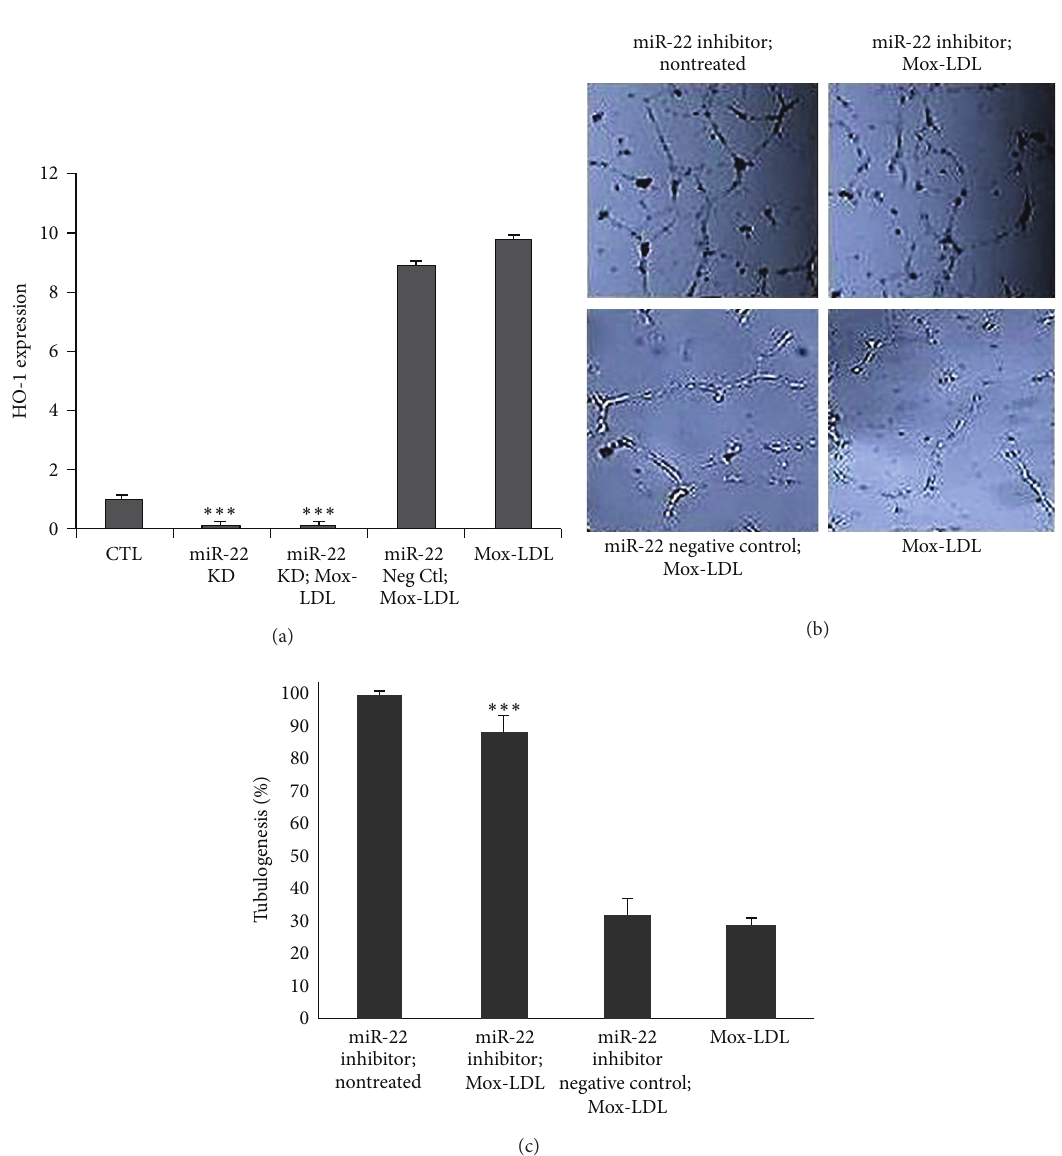
Figure 6: (a) Differential HO-1 expression between HUVECs submitted to different treatments: CTL (control mock-treated cells), miR- 22 K.D (cells treated with miR-22 inhibitor), miR-22 K.D; Mox-LDL (cells treated with miR-22 inhibitor and Mox-LDL), miR Neg Ctl; Mox-LDL (cells treated with control miR and Mox-LDL), and Mox-LDL (cells treated with Mox-LDL). HUVECs were either treated or not with miR-22 inhibitor or miR inhibitor negative control. HUVEC were incubated for 24 hours in culture medium supplemented with mock medium (CTL) or Mox-LDL. Total RNA was extracted and analyzed by qRT-PCR using HO-1-specific primers. Pooled data from 3 independent experiments are shown. ∗∗∗ 𝑃 < 0.001 (Student’s 𝑡 test). (b) The effect of miR-22 knockdown on Mox-LDL treatment in HUVEC tubulogenesis. Representative fields of HUVEC cultures in tubulogenic conditions. HUVECs were either treated or not with miR-22 inhibitor or miR inhibitor negative control. Afterwards, cells were cultured in the presence or absence of Mox-LDL for 24 hours. HUVECs were then seeded on Matrigel supplemented with mock medium (CTL) or Mox-LDL (Mox-LDL) and incubated overnight. (c) Quantification of tubulogenesis in HUVEC cultures. After overnight incubation in Matrigel supplemented with mock medium (CTL) or Mox-LDL (Mox- LDL), pictures were taken of 4.906 mm square fields. Total tubule network length was then measured using the Image J computer program. Shown data are expressed as total tubule network length for each condition and normalized to the “miR-22 inhibitor; nontreated” control condition set as 100%. Mean ± SEM on 3 independent experiments performed in duplicate. ∗∗∗ 𝑃 < 0.001 versus Mox-LDL (ANOVA, Turkey’s multiple comparison